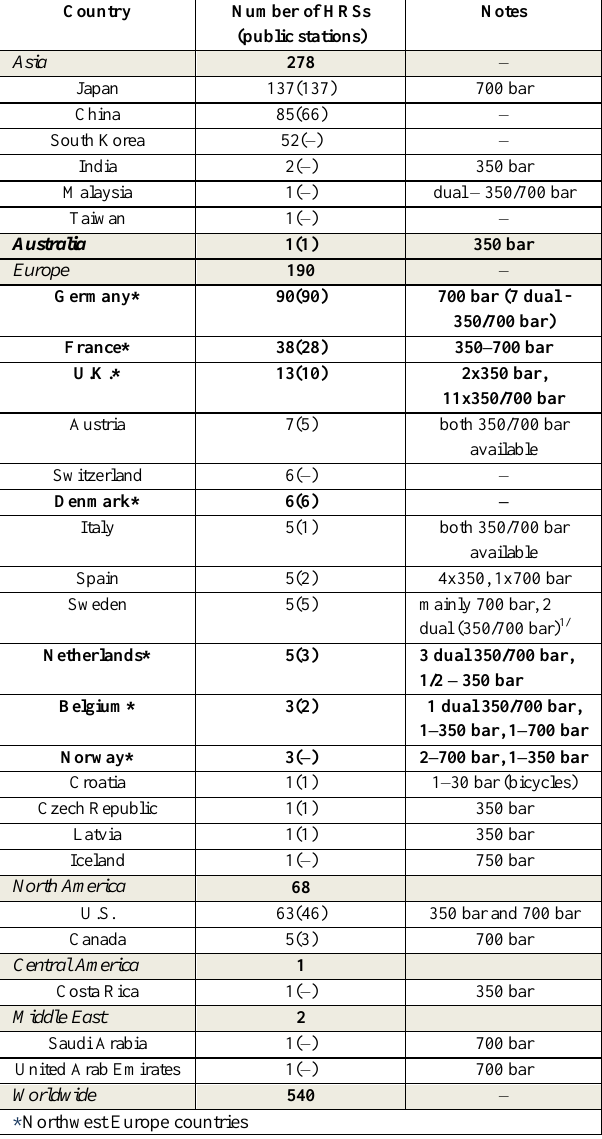
Table 1. Deployment status of HRS in Motor Transport as of the end 2020 at Northwest Europe against the backdrop of the world